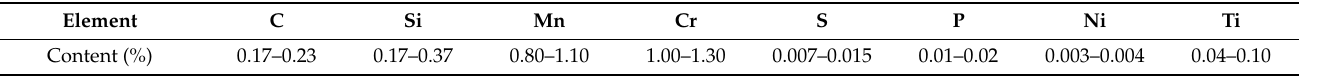
Figure 6. Dry milling machine device for contour bevel gears. (( A ) shows the TRI-AC cutterhead, ( B ) shows the blades, ( C ) shows the Phoenix 175 HC CNC machine, ( D ) shows the gear blank, and ( E ) shows the machined contour bevel gear). Table 4. Chemical constituents of 20CrMnTi.